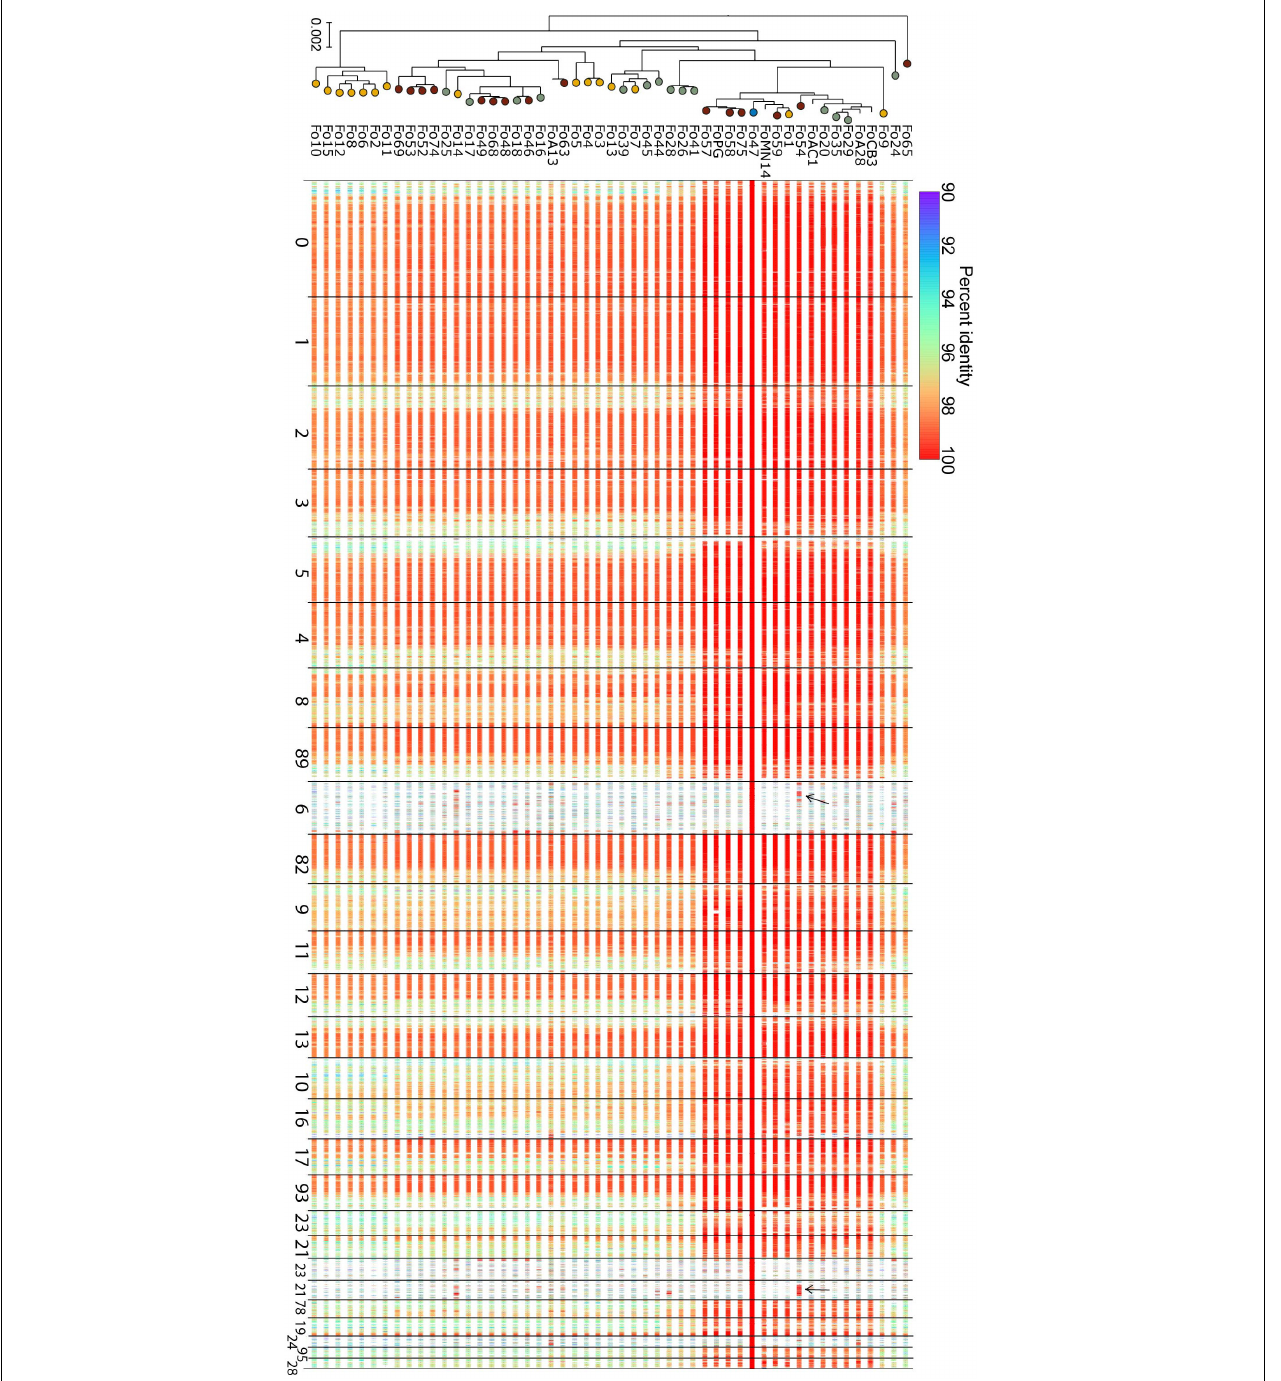
FIGURE 4 | Comparative genomics does not reveal any endophyte-specific genomic regions. Each row depicts the aligned regions that span more than 1 kb in the reference genome and are more than 90% identical in sequence, from a whole-genome alignment between Fo47 and one of the endophyte Fo genomes (incl. Fo47 itself) in our dataset. Rows are ordered according to position in the phylogenetic tree (left, this is the same tree as in Figure 1 , except for the fact that all pathogenic isolates have been removed). Lines are color-coded according to percent identity (see scale on top of the panel), where red lines represent 100% identical sequences. Most contigs are highly conserved among different Fo strains: these are considered core contigs. In contrast, large accessory contigs, such as contig 6, 21, 78, and 95 are less conserved (see also Supplementary Figure 2 ). Few regions of Fo47 accessory material are shared among other isolates, for example, part of contig 6 and contig 78 is shared with Fo54 (indicated with black arrows). The high level of sequence identity of these shared accessory regions, compared to the level of sequence identity of core regions, suggests these regions were horizontally transferred between the two Fo lineages.